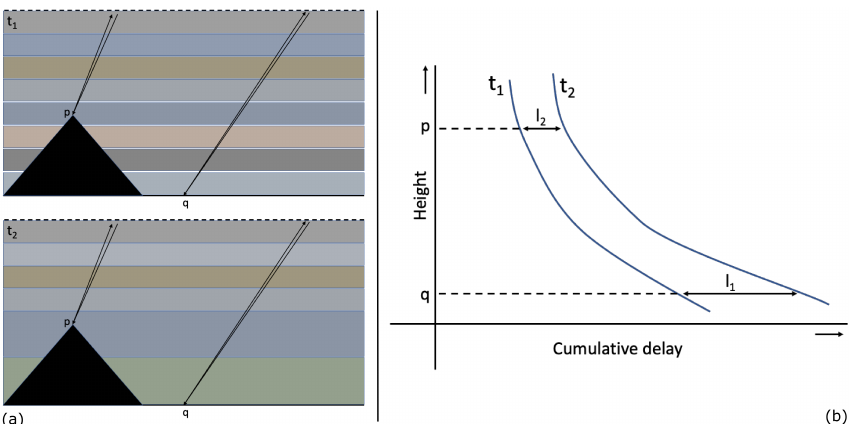
Figure 1. ( a ) Differential tropospheric delay between point p at a higher altitude than point q with different refractivity profiles at times t 1 and t 2 , and ( b ) cumulative delay at times t 1 and t 2 between points p and q : the differential delay between between points at different altitudes are determined by the difference between l 1 and l 2 . Figure adapted from